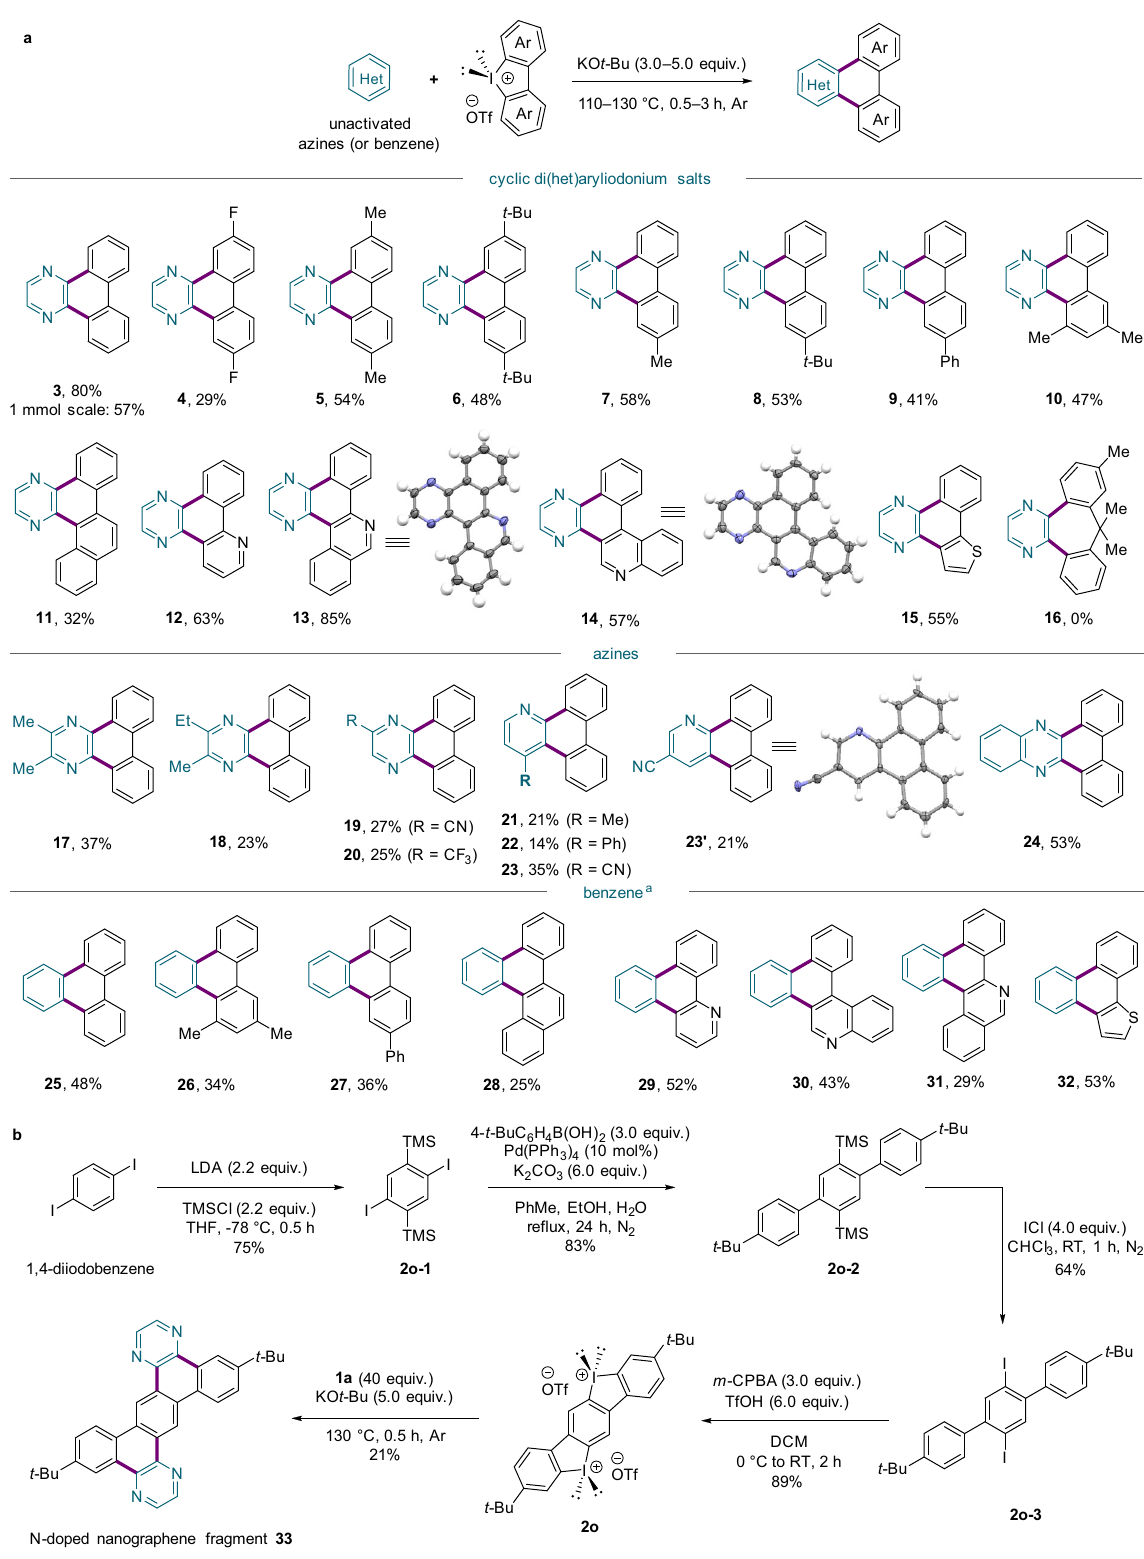
Fig. 3 Scope of transition-metal-free APEX reactions. a Reactions were carried out on a 0.20 mmol scale for cyclic aryliodonium salt 2 . a Conditions for reactions with benzene: 1a (2.0 equiv., used as an additive), 2 (1.0 equiv.), KO t -Bu (5.0 equiv.) in benzene (2 mL) at 110 °C under Ar for 3 h. b Access to an N-doped nanographene fragment. Isolated yields are